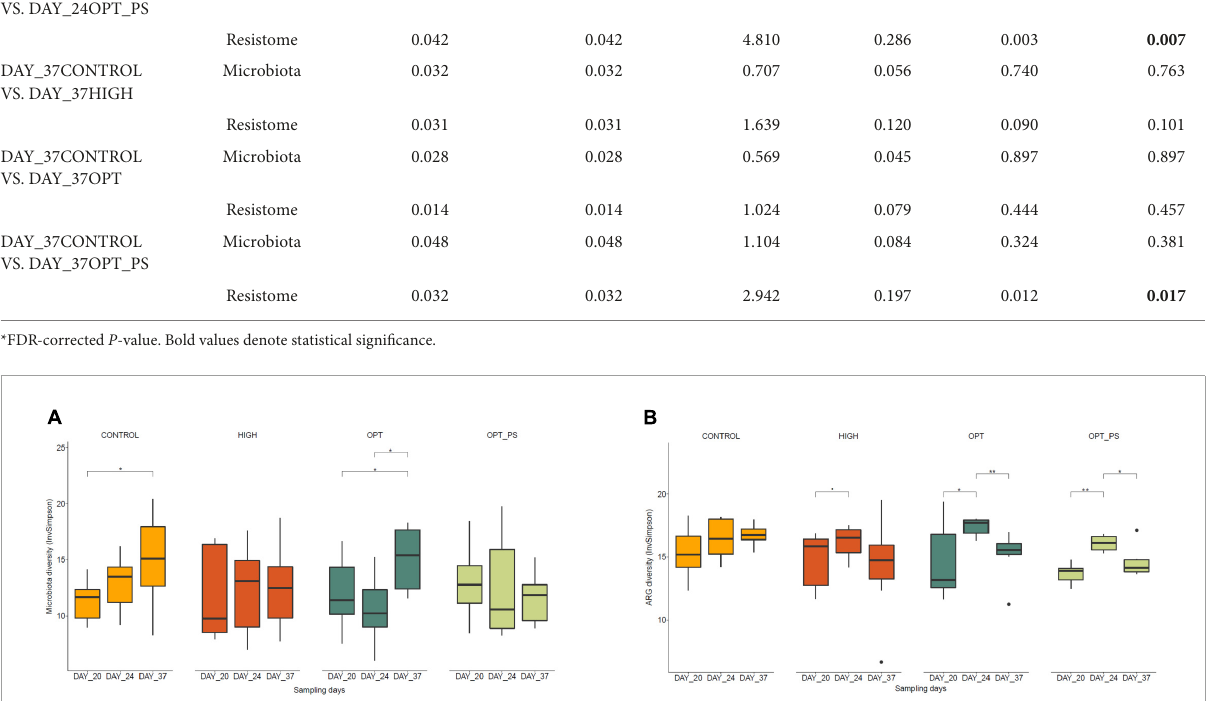
by species from Firmicutes and Actinobacteria ( Figure 5A and Supplementary Data 1 ). In fact, over the course of the enrofloxacin application (days 21–23), both high and optimized dose application resulted in a significant (FDR-corrected p -value < 10%) increase in the abundance of 17 proteobacterial species, while significantly reducing the abundance of 15 proteobacterial species ( Figure 5B and Supplementary Data 1 ). Two weeks after the last day of antibiotic application,